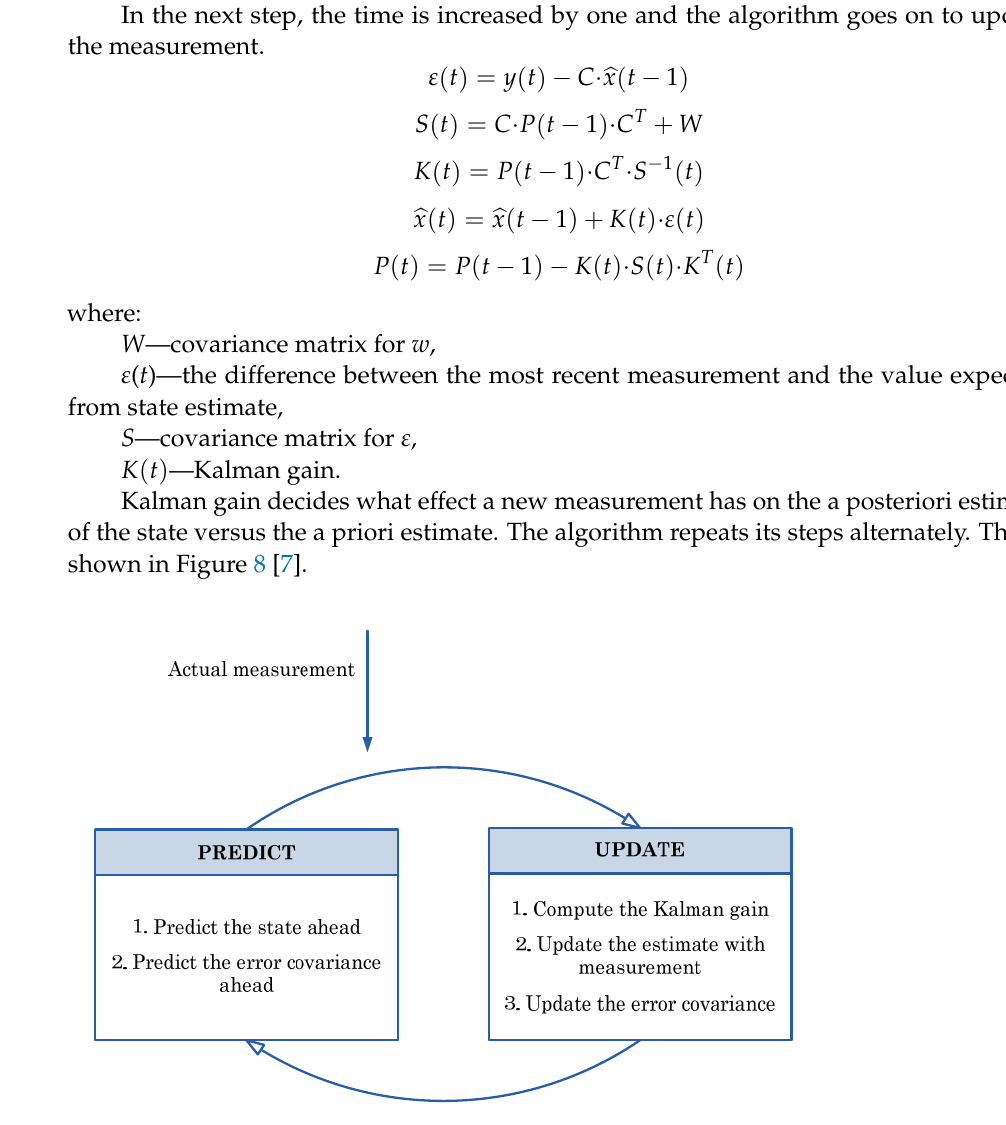
Figure 8. Two steps Kalman filter algorithm.